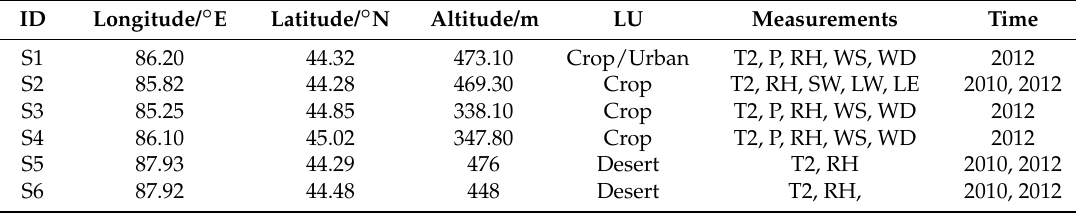
Table 1. Meteorological stations’ names, locations, elevations, and available